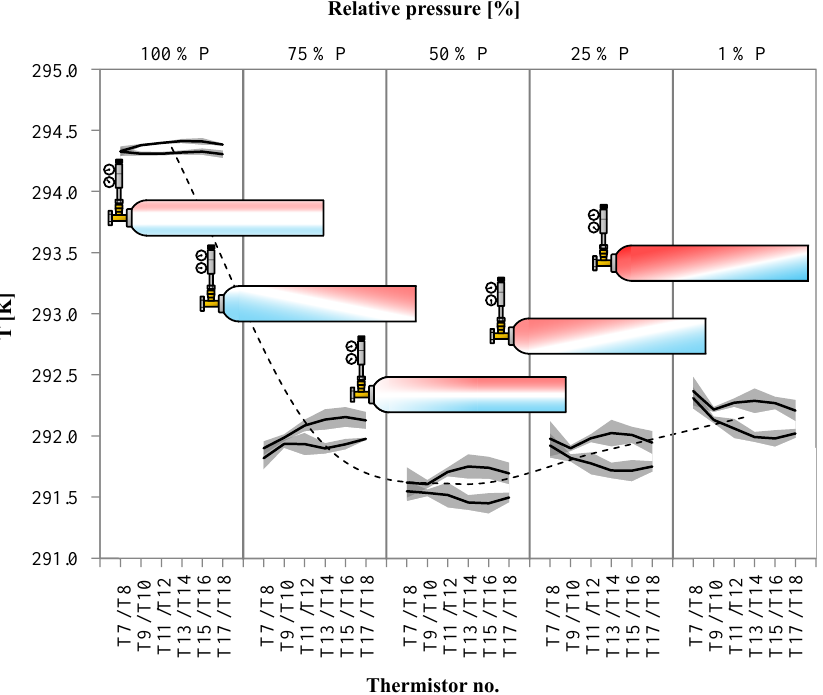
Figure 11. Temperature difference between the upper and the lower side of the cylinder (in horizontal position) at five different stages of decanting. The temperature is given on the y axis, the black lines are the average temperature along the upper and lower side of the cylinder derived from three runs; the shaded areas correspond to the standard deviation. The position of the temperature measurement along the cylinder is given for each stage individually on the x axis in the form of the thermistor number (see Fig. 5); the relative pressure is given as bins on the secondary x axis. The black dashed line serves as an indicator for the general temperature development of the cylinder; it corresponds to the average of T11 to T14. The red and blue colors in the cylinders represent a possible distribution of warm (red) and cool (blue) air within the cylinder derived from the temperature measurements on the outside of the cylinder.